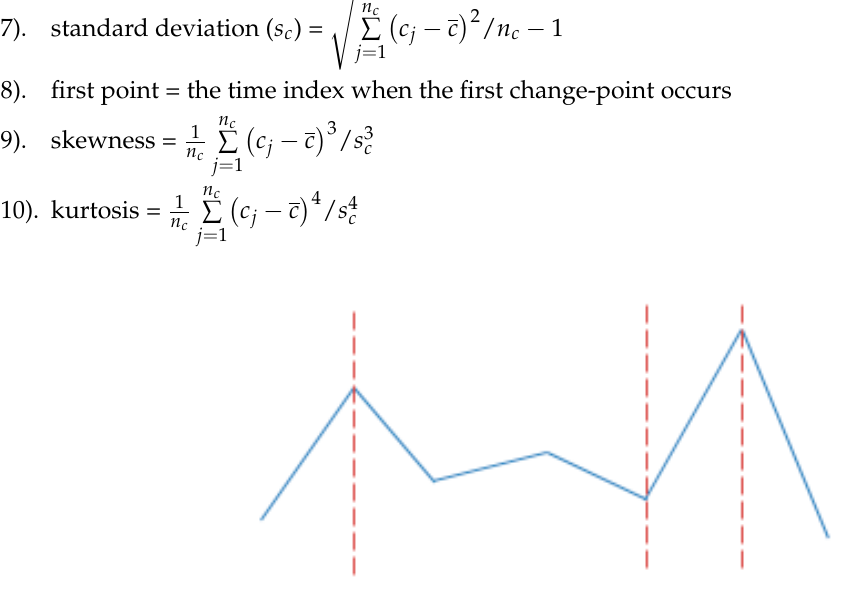
Figure 4. Change-points identified by piecewise linear segmentation